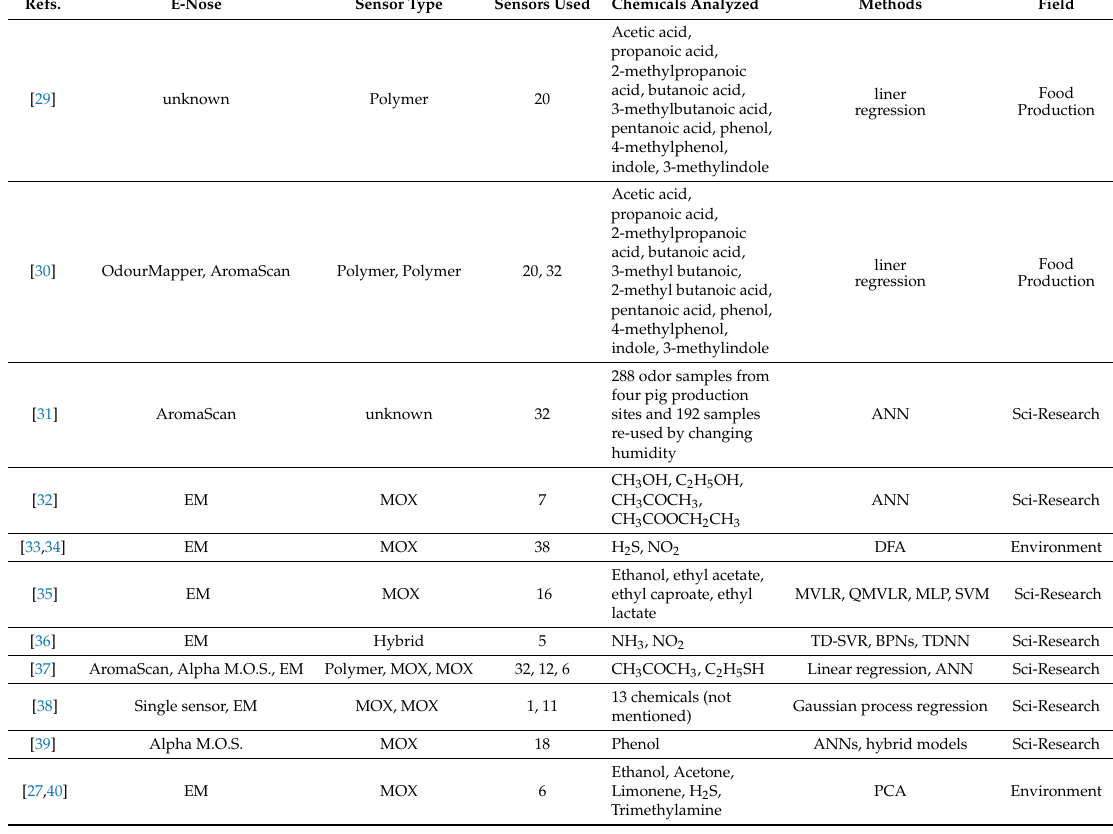
Table 1. Summary of gas/odor concentration estimation research works. QMVLR, quadratic multivariate logarithmic regression; TD-SVR, tapped delay lines and support vector machine.